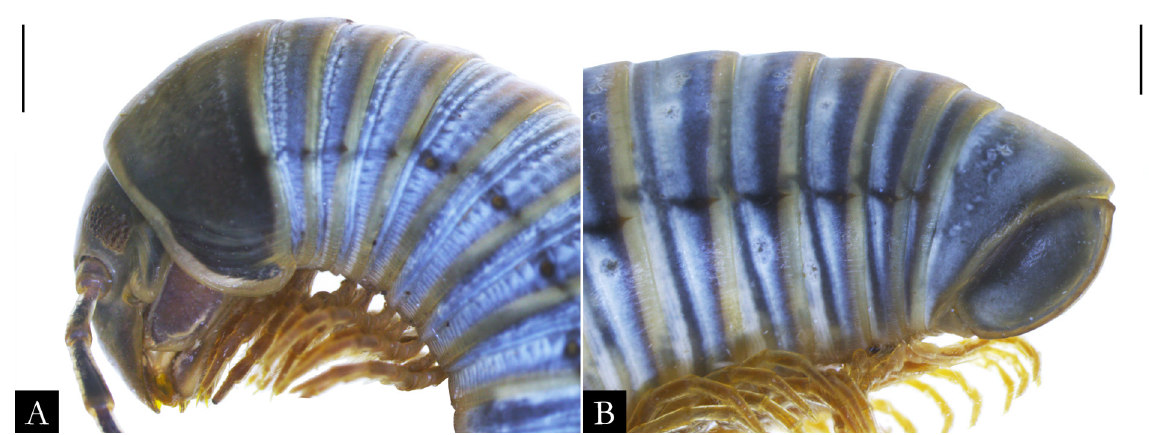
Fig. 66. Pseudonannolene erikae Iniesta & Ferreira, 2014, ♀ (IBSP 3331), in lateral view. A . Anterior region. B . Posterior region. Scale bars = 1